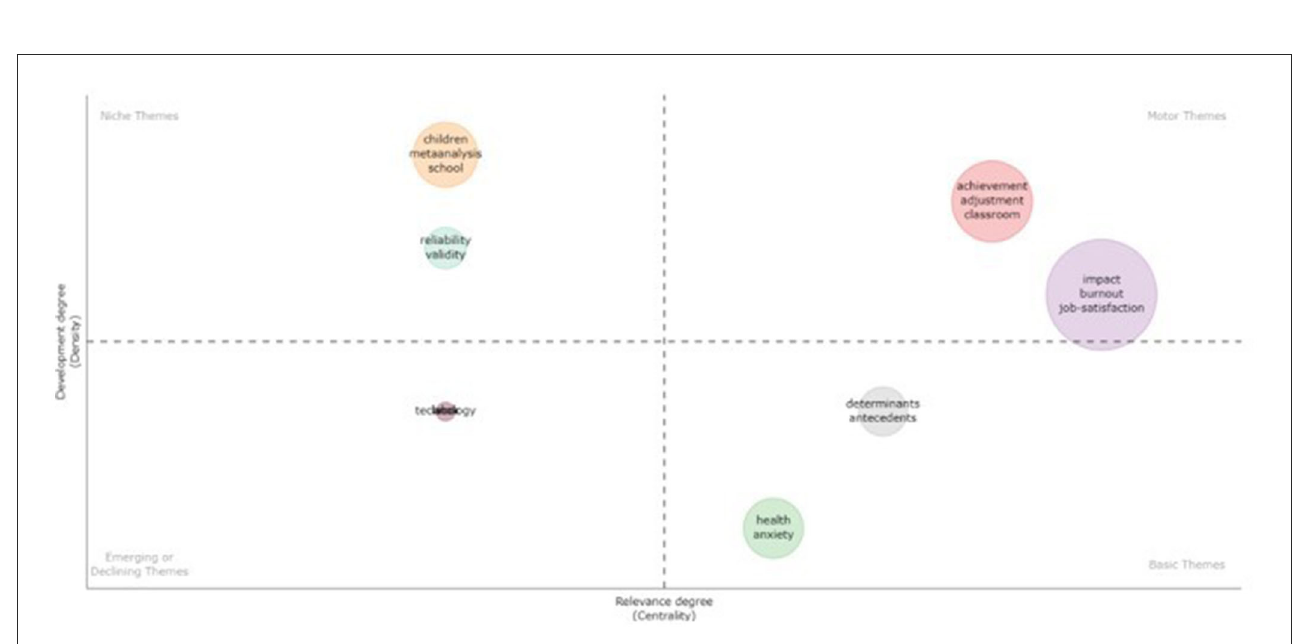
FIGURE10 Strategic diagram of teachers’ job insecurity during the